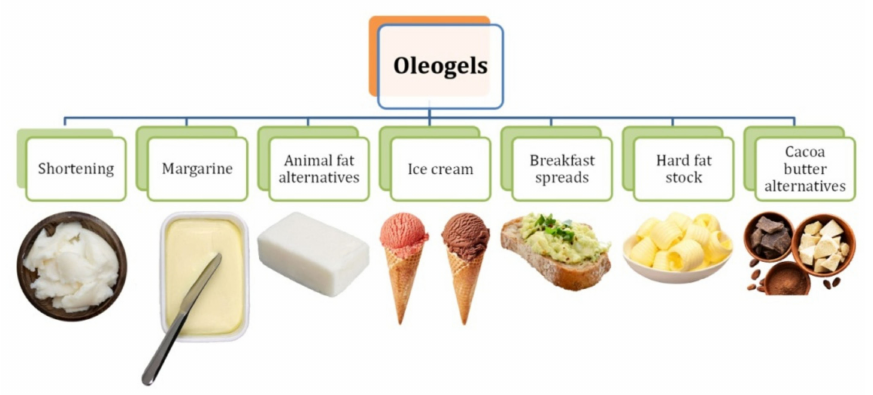
Figure 4. Products dedicated for possible oleogel